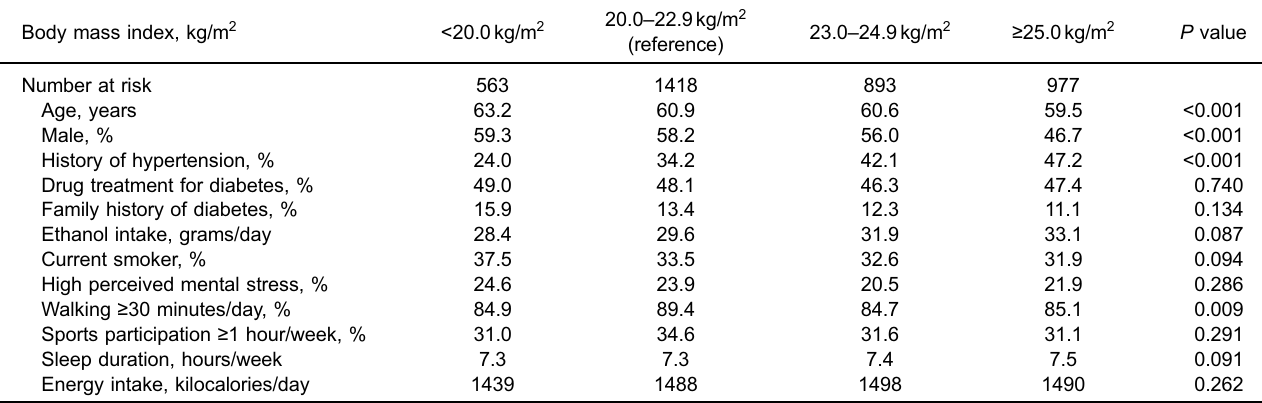
Table 1. Age- and sex-adjusted mean values and prevalence of baseline characteristics according to body mass index Body mass index, kg/m 2